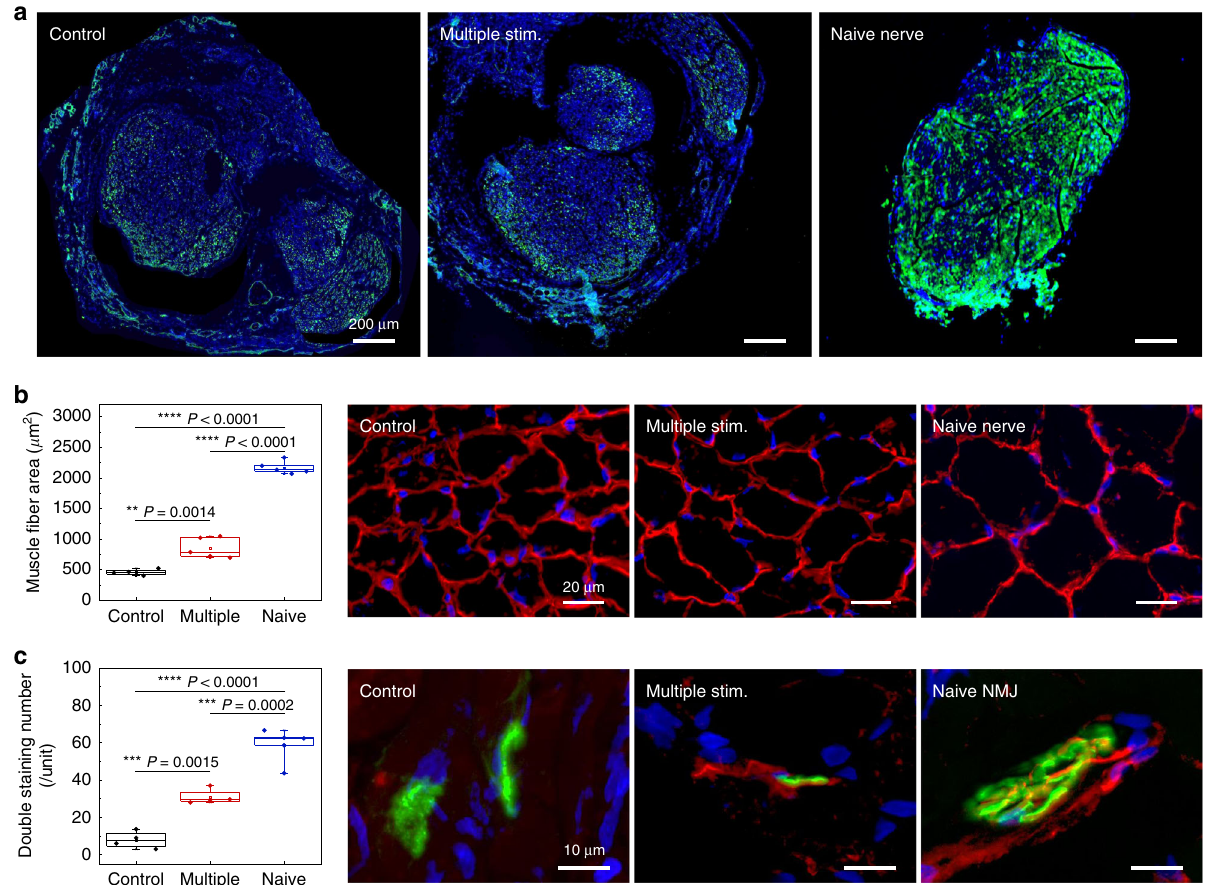
Fig. 5 Histological evidence of improved muscular recovery by multiple episodes of distal nerve stimulation 6 weeks after nerve injury. a Stained slices show no signi fi cant difference in mature axon (Tuj1, green color) signals in the regenerated nerve within the nerve conduit, indicating that the bene fi cial effect of motor recovery is not via accelerated axon regeneration. n = 3 repeated independently with similar results. b Immunohistochemical staining of the muscle fi ber boundary (laminin, red color) reveals an increased muscle fi ber surface area in the group with multiple episodes of distal nerve stimulation. n = 4 biologically independent animals. c Double staining of the neuromuscular junction demonstrates signi fi cantly increased overlapping of pre- (NFM, red color) and postsynaptic (alpha-bungarotoxin, green color) staining for the group with multiple episodes of distal nerve stimulation, indicating an enhanced number of neuromuscular junction (NMJ) and muscle reinnervation. Naive indicates mice with uninjured nerve. n = 4 biologically independent animals. The boxplots show the median (center line), the third and fi rst quartiles (upper and lower edge of the box, respectively), and the largest and smallest value that is ≤ 1.5 times the interquartile range (the limits of the upper and lower whiskers, respectively). Statistical software (Version 6.0) was used for the analysis followed by a t-test and one-way ANOVA with Tukey multiple comparison analysis (* P < 0.05; ** P < 0.01; *** P < 0.001; **** P < 0.0001). Data available in source data fi le.